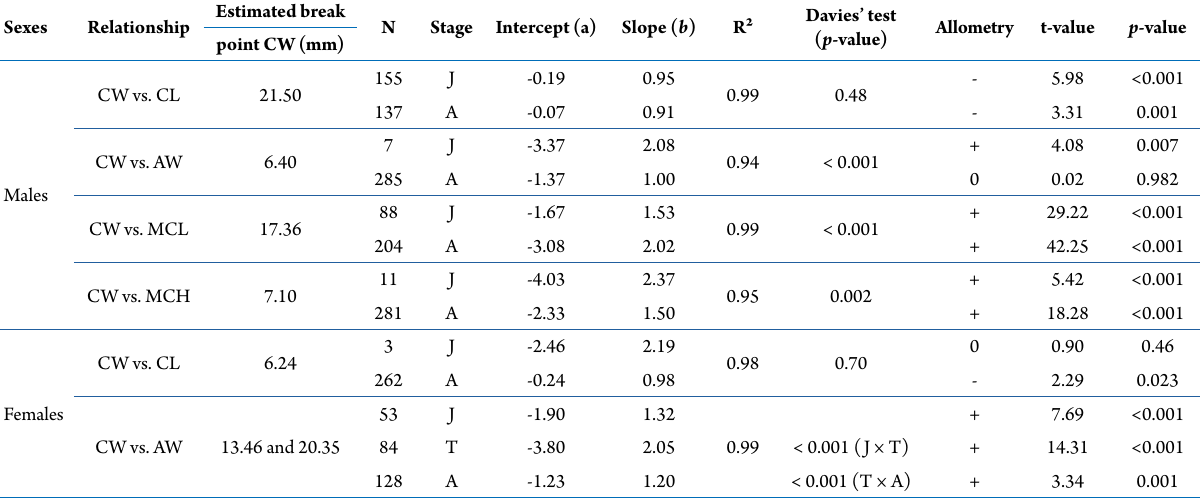
Table 2. Regression models with segmented relationship for males and females of Uca maracoani , Davies’ test for difference between consecutive slopes and t-test for deviations of slope ( b ) from 1. Estimated Sexes Relationship